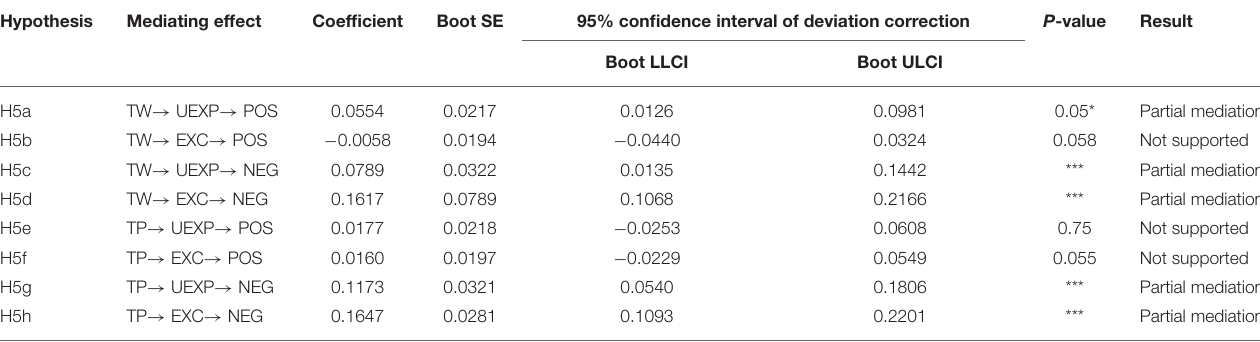
TABLE 5 | Intermediary inspection